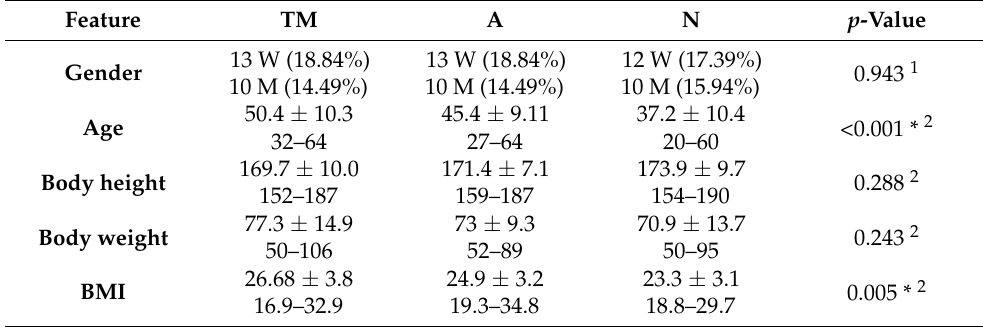
Table 1. Characteristics of the respondents from particular groups in terms of basic biometric data.